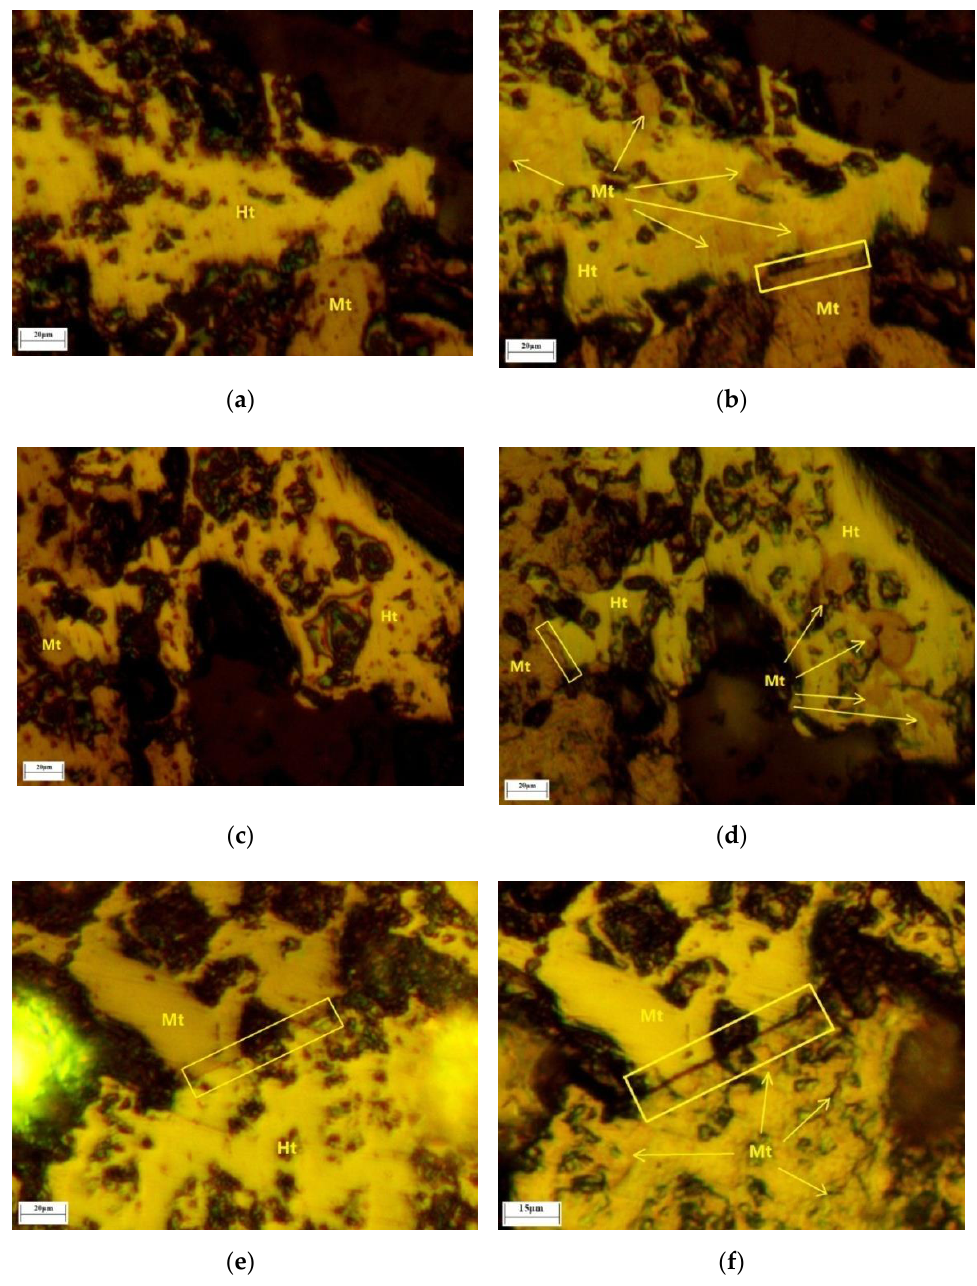
Figure 16. The continuous magnetization roasting process of magnetite and hematite intergrowth. ( a ) Site 1; 0 s, ( b ) Site 1; 300 s, ( c ) Site 2; 0 s, ( d ) Site 2; 300 s, ( e ) Site 3; 0 s, ( f ) Site 3; 300